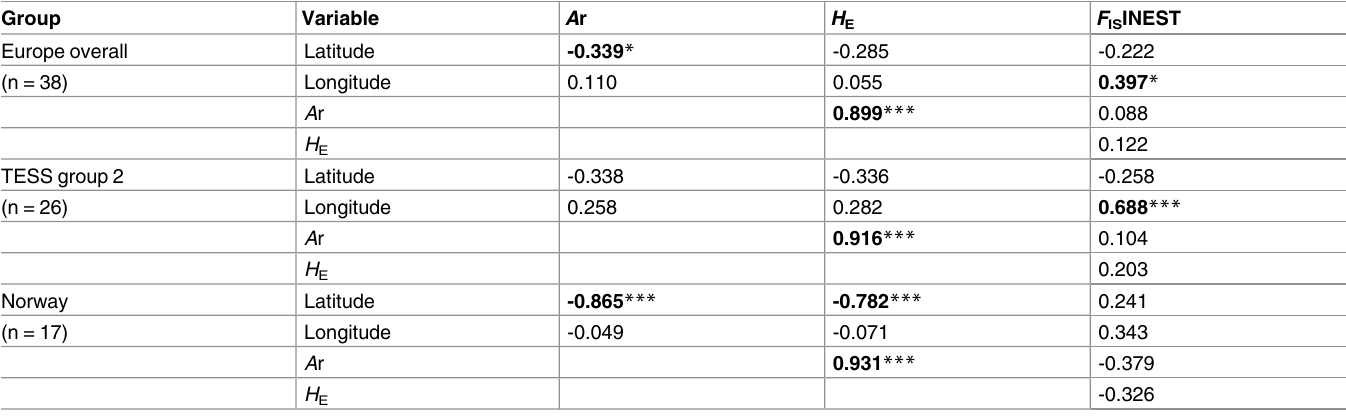
* and *** denote significant correlations at the 5 and 0.1% levels,